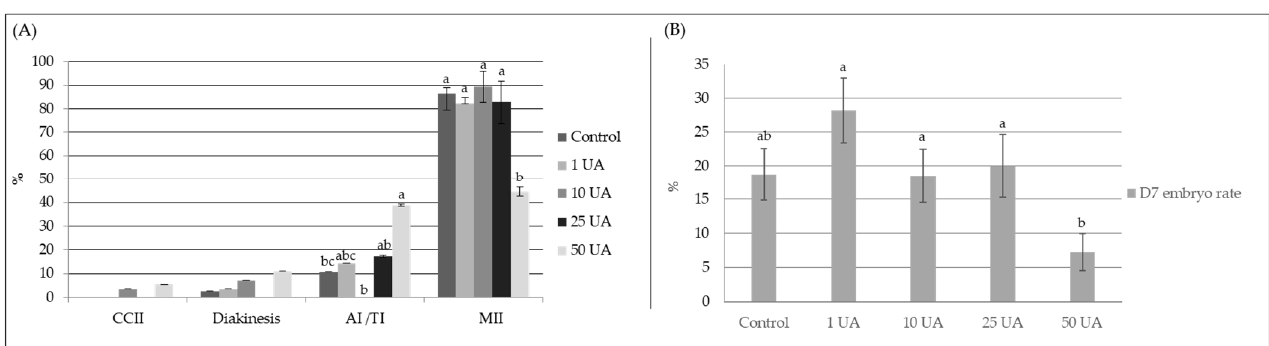
Figure 1. Effect of Urolithin A (UA) doses (control, 1 UA, 10 UA, 25 UA, and 50 UA, correspond to 0, 1, 10, 25 and 50 μ M of UA, respectively) supplemented to the maturation medium on: ( A ) oocyte chromosomal configuration. Different letters indicate significant differences between groups for the same stage (CCII, condensing chromosomes II; AI/TI, Anaphase- I/Telophase-I; MII, Metaphase-II, p ≤ 0.05); ( B ) D7 embryo rate. Different letters indicate significant differences between groups ( p ≤ 0.05). D7, day 7.